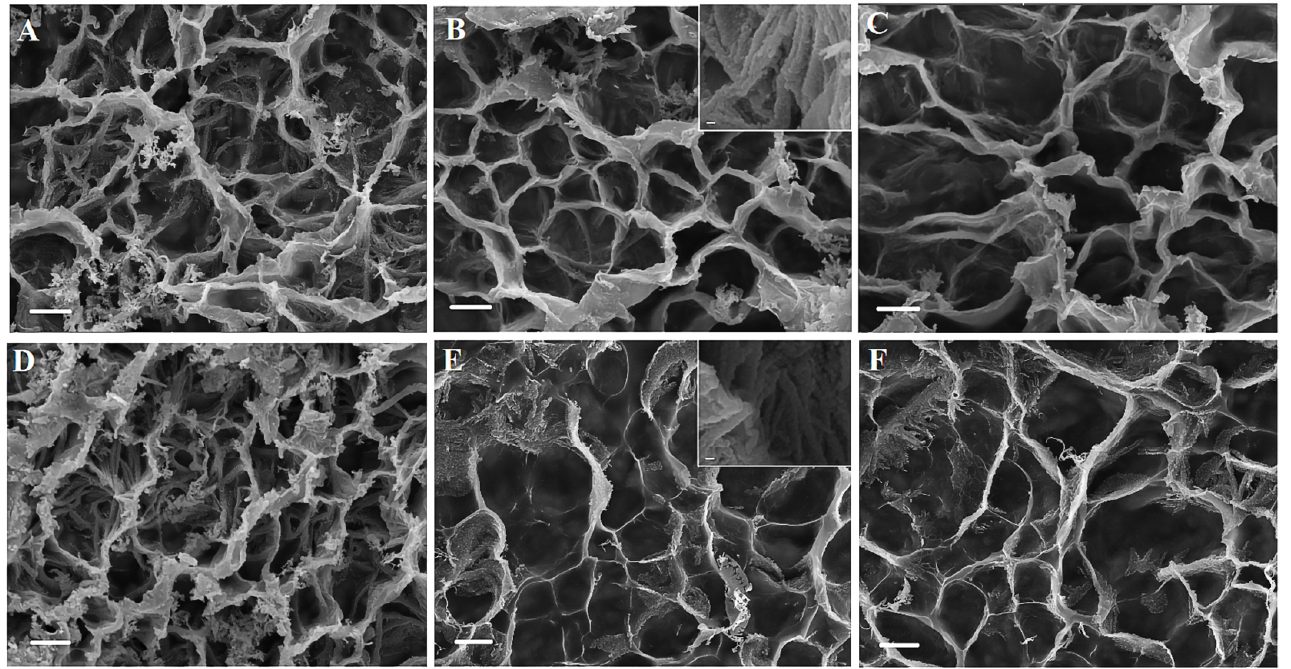
Figure 4. SEM images of lyophilized 15 wt% SerAte-UM hydrogels with degree of modification of 24% ( A ), 31% ( B ), and 40% ( C ) at 1100× magnification. SEM images of lyophilized 15 wt% SerAte-M hydrogels with degree of modification of 24% ( D ), 31% ( E ), and 40% ( F ) at 1100× magnification. The insets in ( B – E ) show higher magnification (3000×) SEM images of SerAte-UM and SerAte-M hydrogels, respectively, with 31% degree of modification. The scale bar in ( A – F ) is 10 µ m and that in the insets of ( B , E ) is 0.5 µ